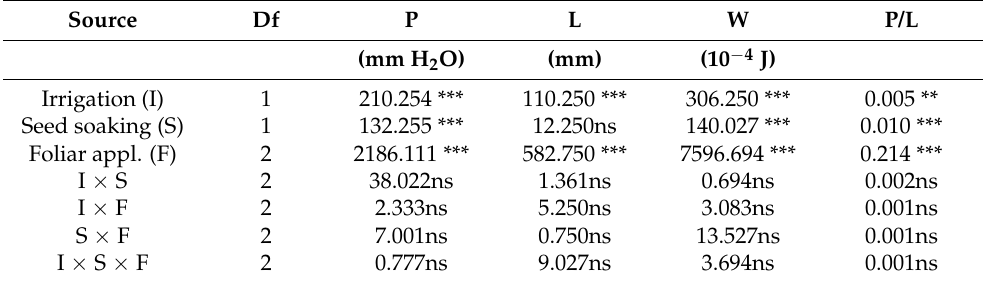
Table 9. Analysis of variance (mean square) of alveographic parameters of wheat grains.